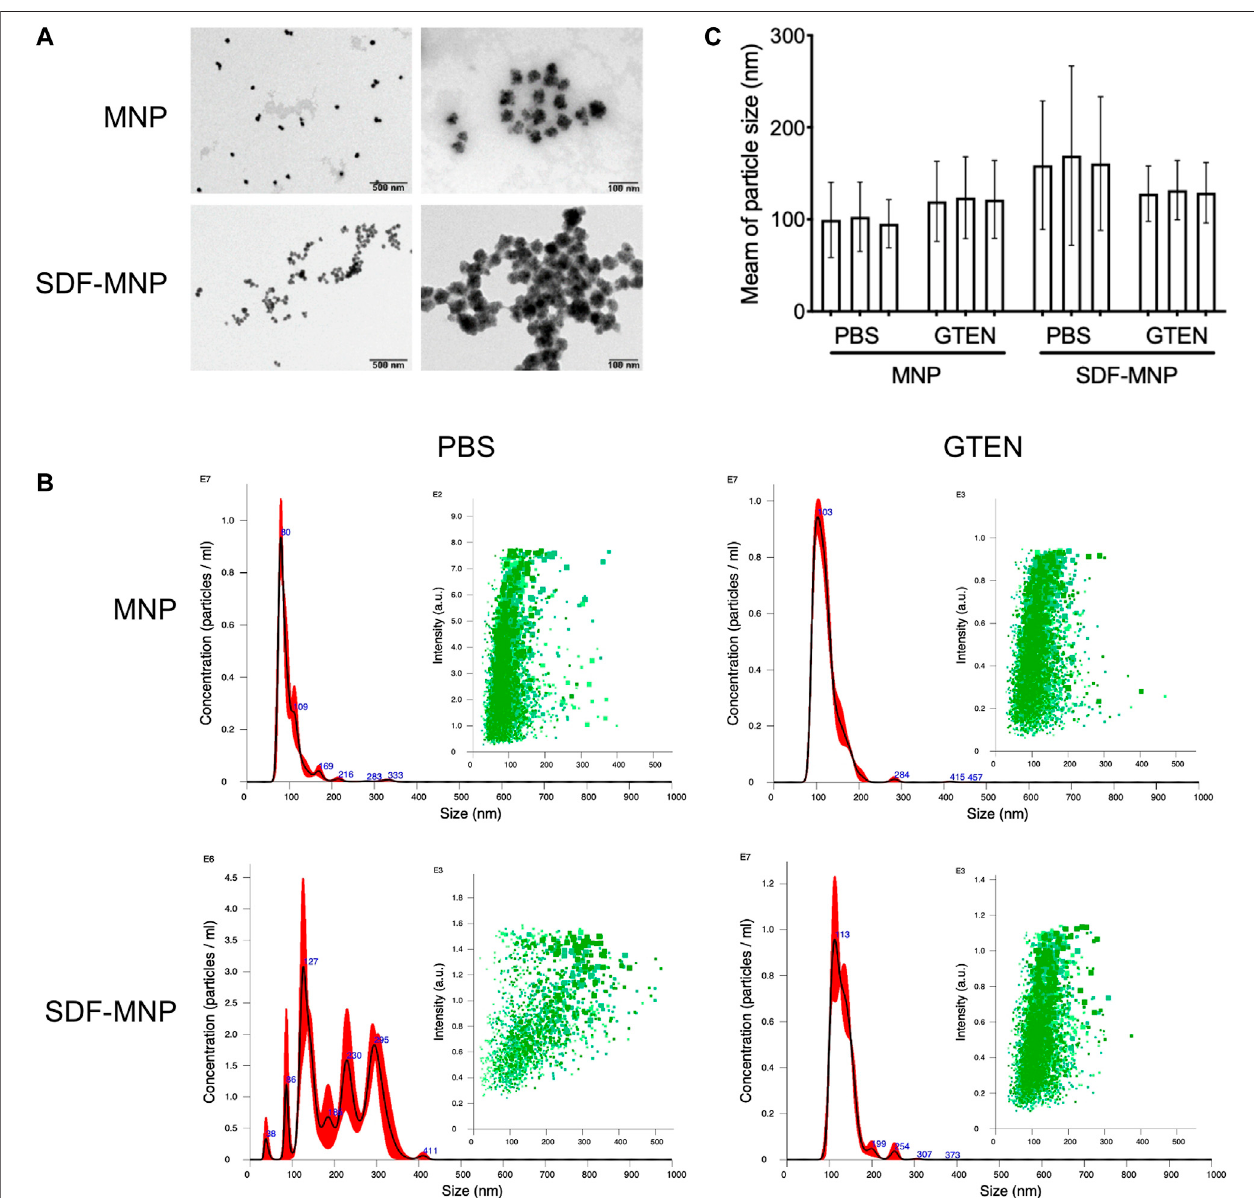
FIGURE 3 | Characteristic of SDF-MNP. (A) TEM images of MNP and SDF-MNP. Scale bars: left, 500 nm; right, 100 nm. (B) Hydrate particle size – concentration histogram (red) and scatter plot (green) of MNP and SDF-MNP in PBS or GTEN buffer. (C) Statistical mean of particle size in every test. Particle size was measured in three